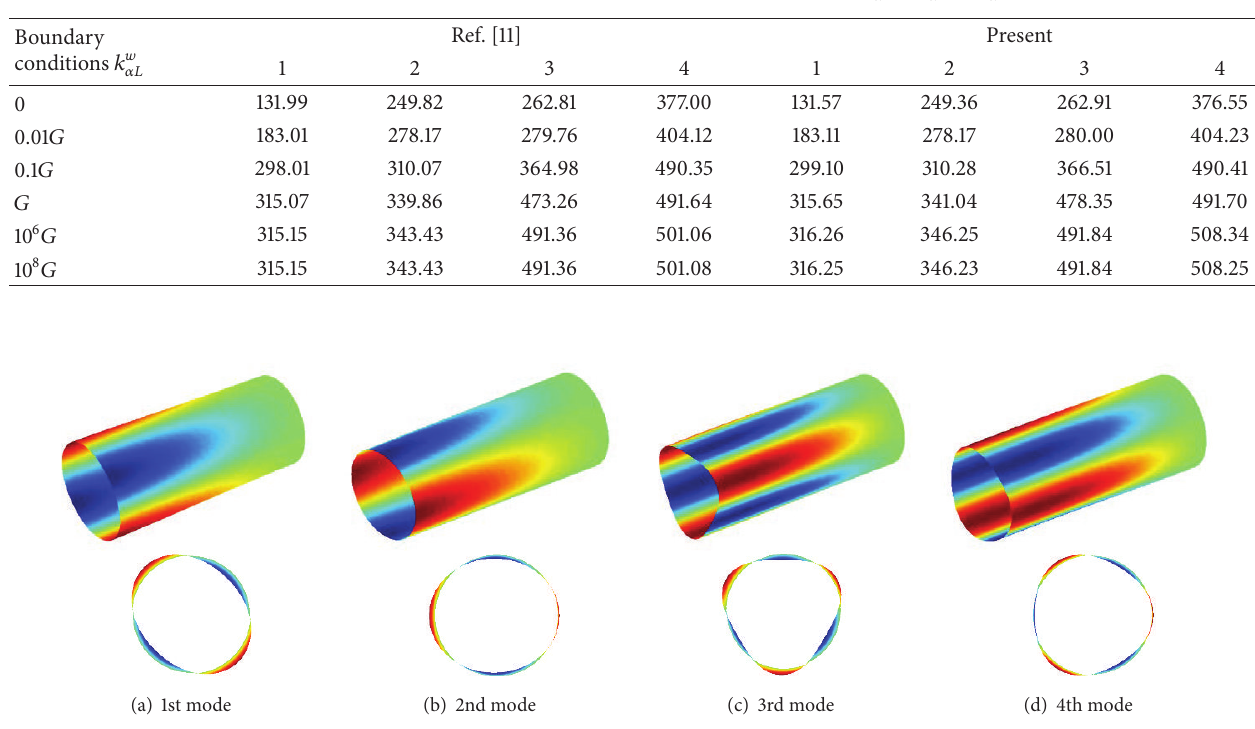
Figure 10: First four mode shapes for closed cylindrical shells with one boundary end clamped and another end elastically supported ( 𝑘 𝑢 𝛼𝐿 = = 𝐾 𝑤 = 0 and 𝑘 𝑤 = 0.01𝐺 𝑘 V 𝛼𝐿 𝛼𝐿 𝛼𝐿